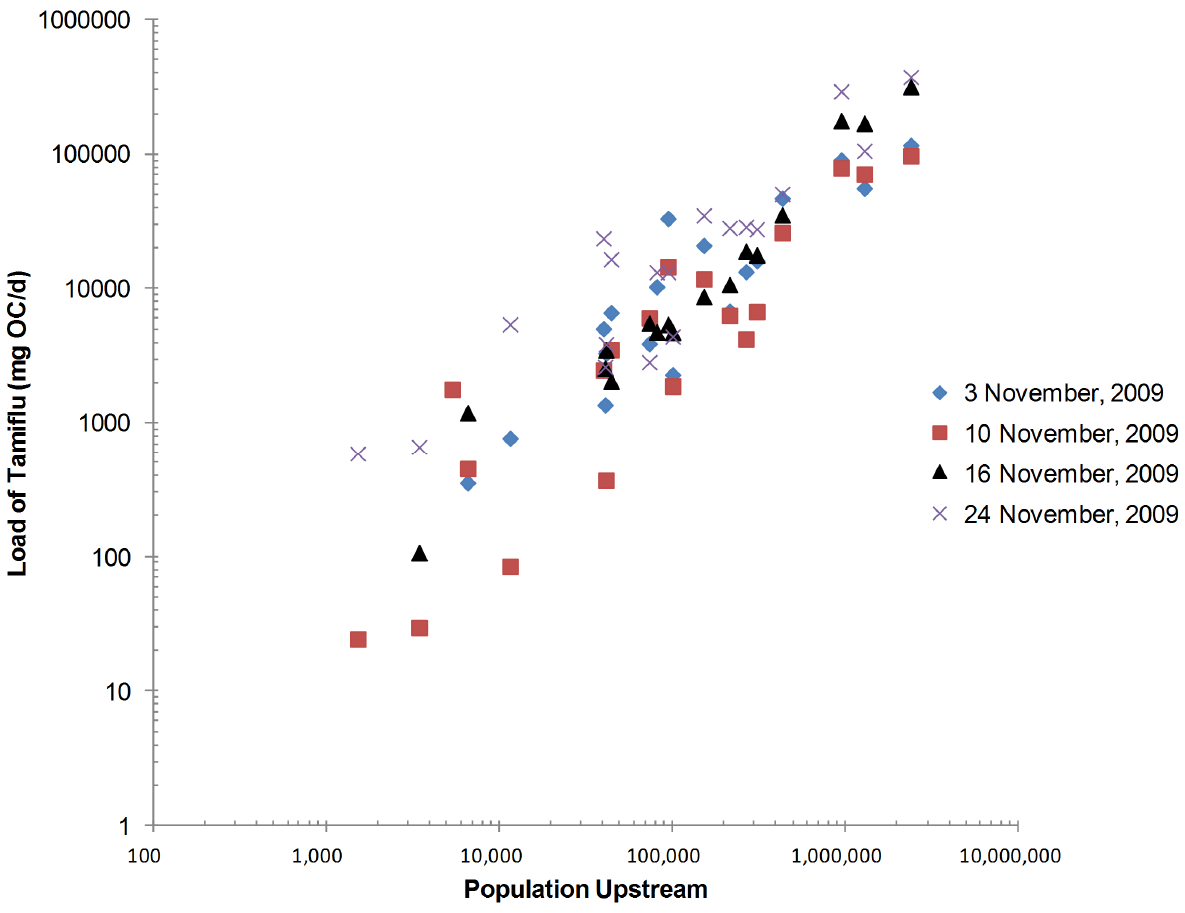
Figure 2. Correlation between population upstream and daily load of OC in river (mg OC/d) for each of the four sampling points: November 3 (diamond), November 10 (square), November 16 (triangle) and November 24 (‘x’), 2009.